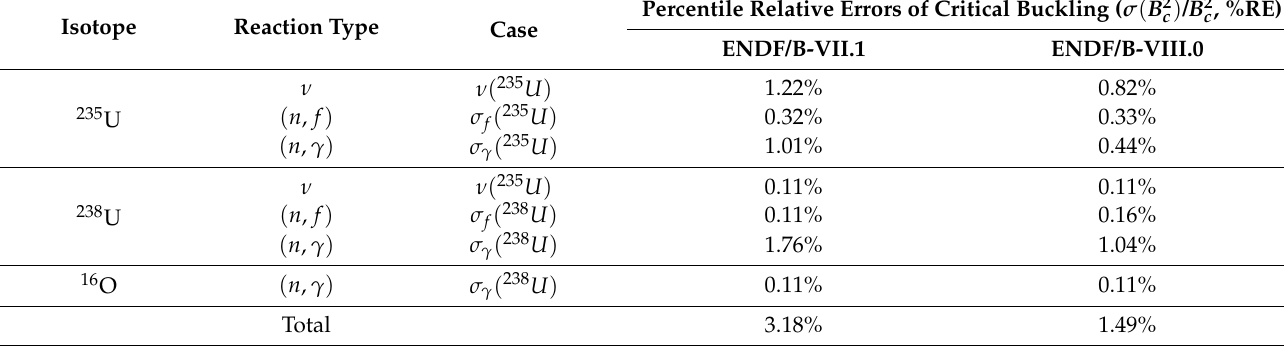
Table 6. Uncertainties of critical buckling based on cross section uncertainties (Problem 1).